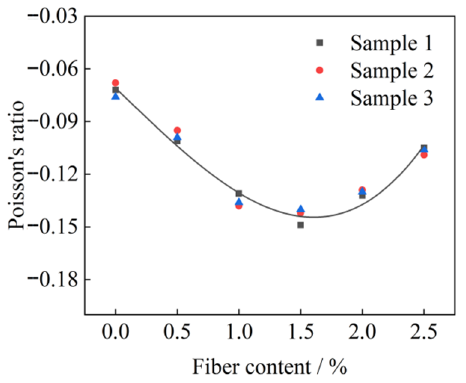
Figure 7. Effect of fiber content on Poisson’s ratio of concave hexagonal unit cells.